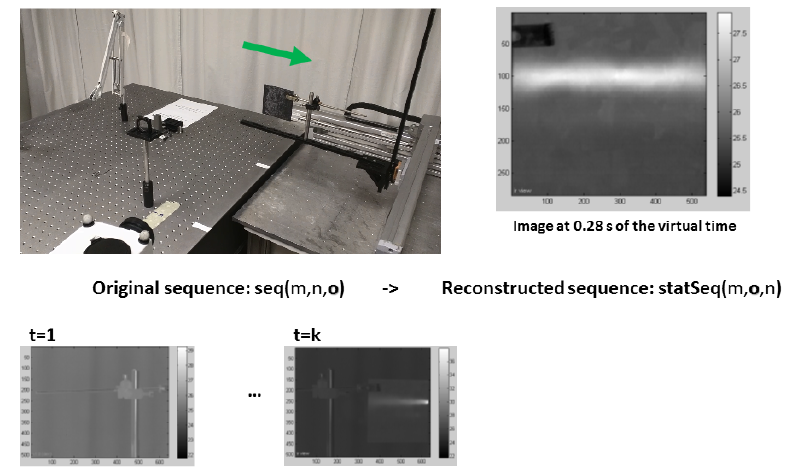
Figure 2. Pseudo-static sequence reconstruction. At the bottom of the figure, two images from the original sequence at different times are shown. Above these images, the experimental set-up is shown: the IR camera and the inspected sample can be seen as well as the 2-axis electric actuator used to displace the sample. The green arrow indicates the direction of displacement. On the right, an image from the reconstructed pseudo-static sequence is shown. Adapted from